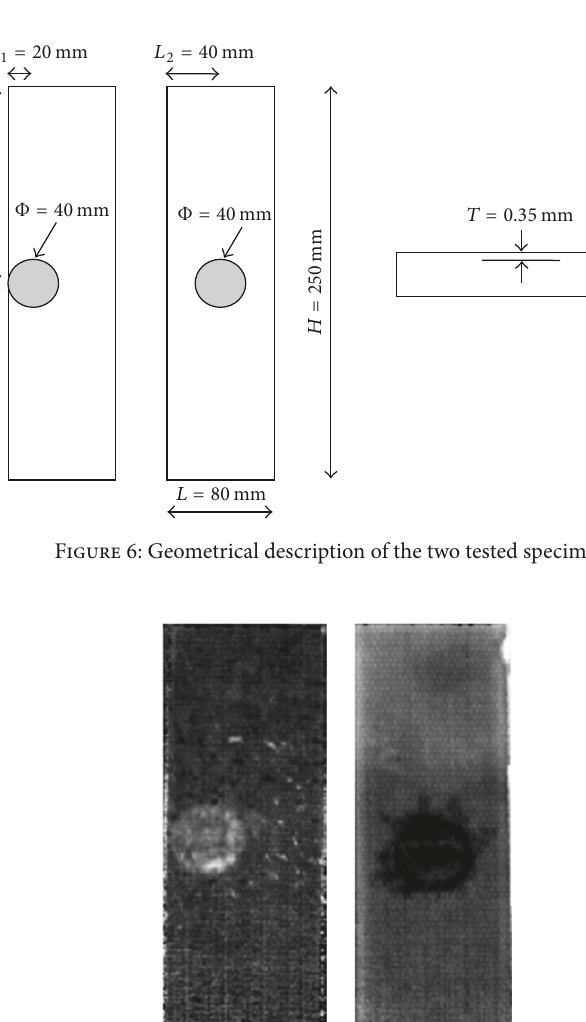
Figure 5: Example of the calibration grid.